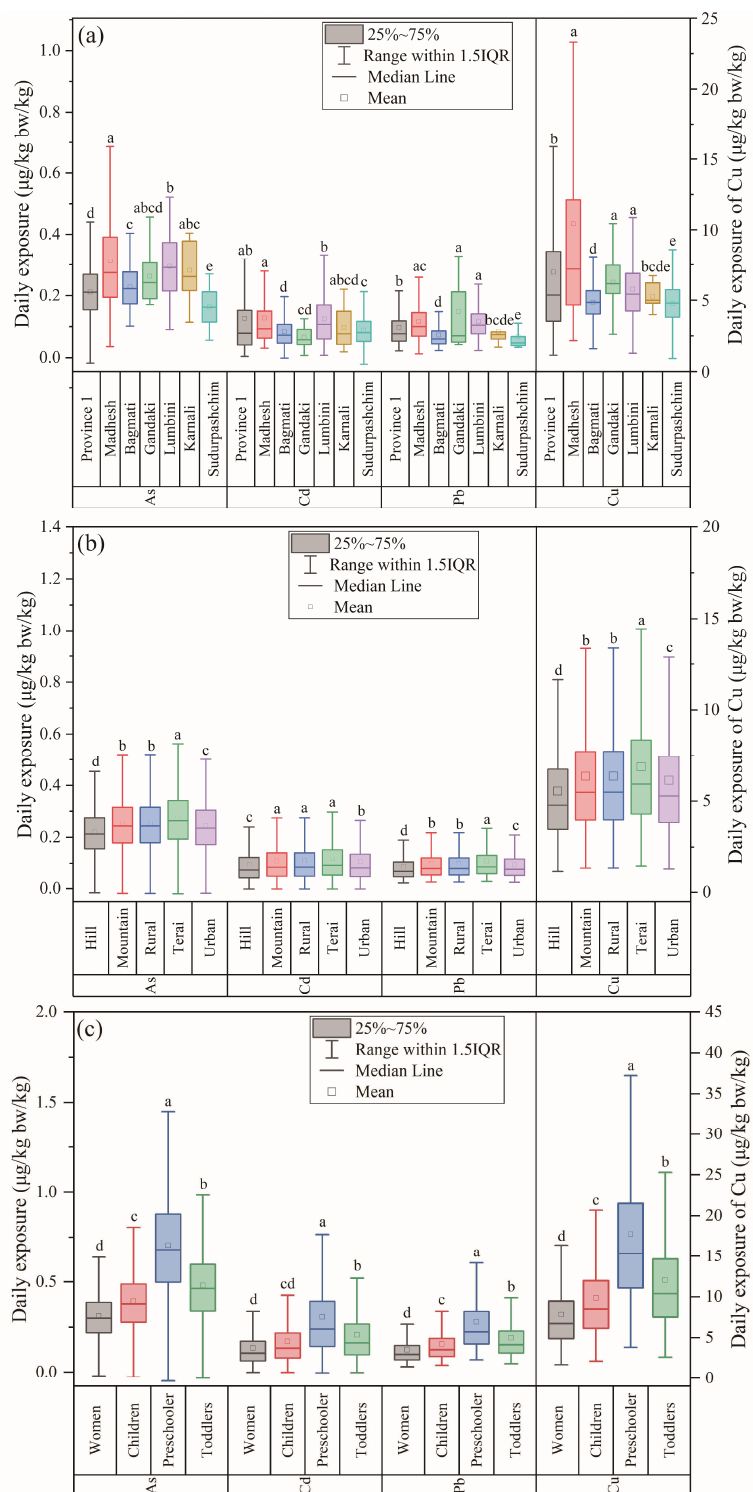
Figure 3. (a) EDI distribution of As, Pb, Cd, and Cu in different provinces, (b) EDI distribution of As, Pb, Cd, and Cu in different regions, and (c) EDI distribution of As, Pb, Cd, and Cu for vulnerable populations in Nepal. Note: different lower case letters suggest the significant difference at level p < 0.05.